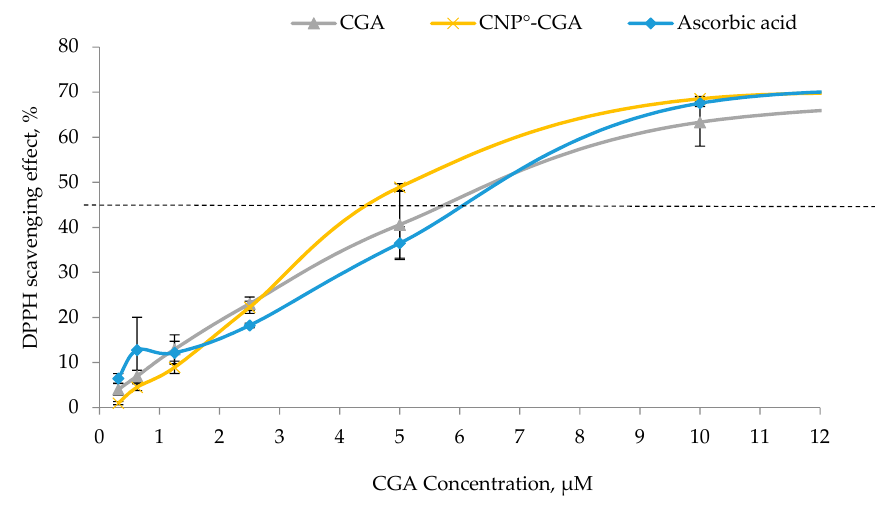
Figure 10. Antioxidant capacity of CGA, CNP°-GCA and ascorbic acid as standard at different concentrations. Error bars represent the SD of three independent replicates of the experiment. Dotted line indicates the IC 50 .